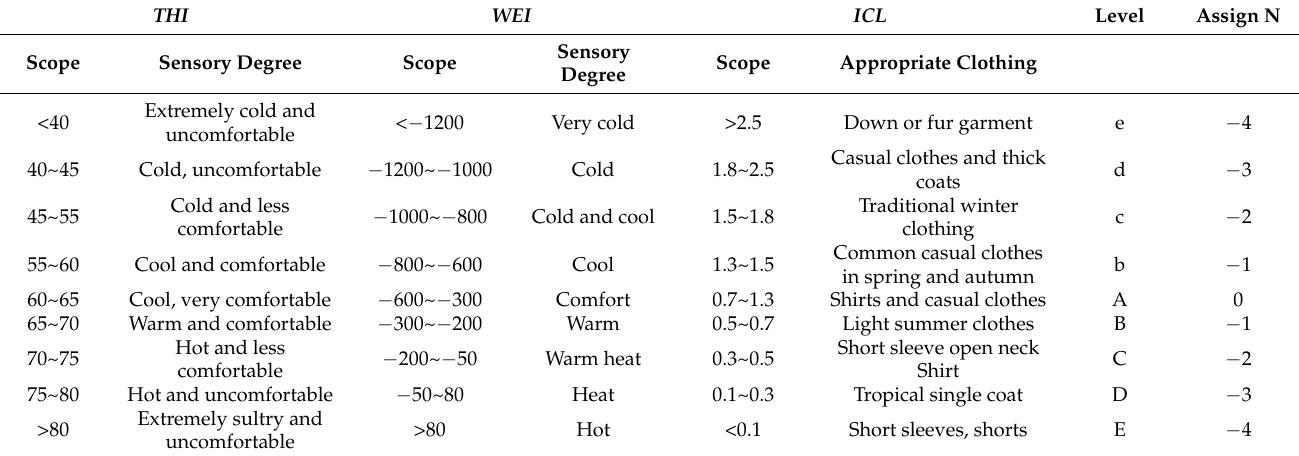
Table 1. Grading standard and assignment of the THI, WEI and